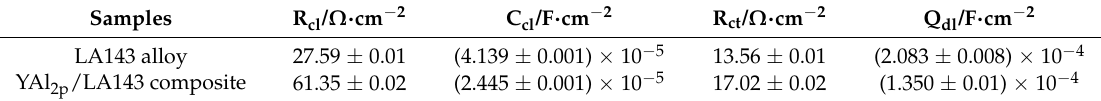
Table 2. The parameters of the equivalent circuit of LA143 and YAl 2p /LA143 in 3.5 wt.% NaCl solution.